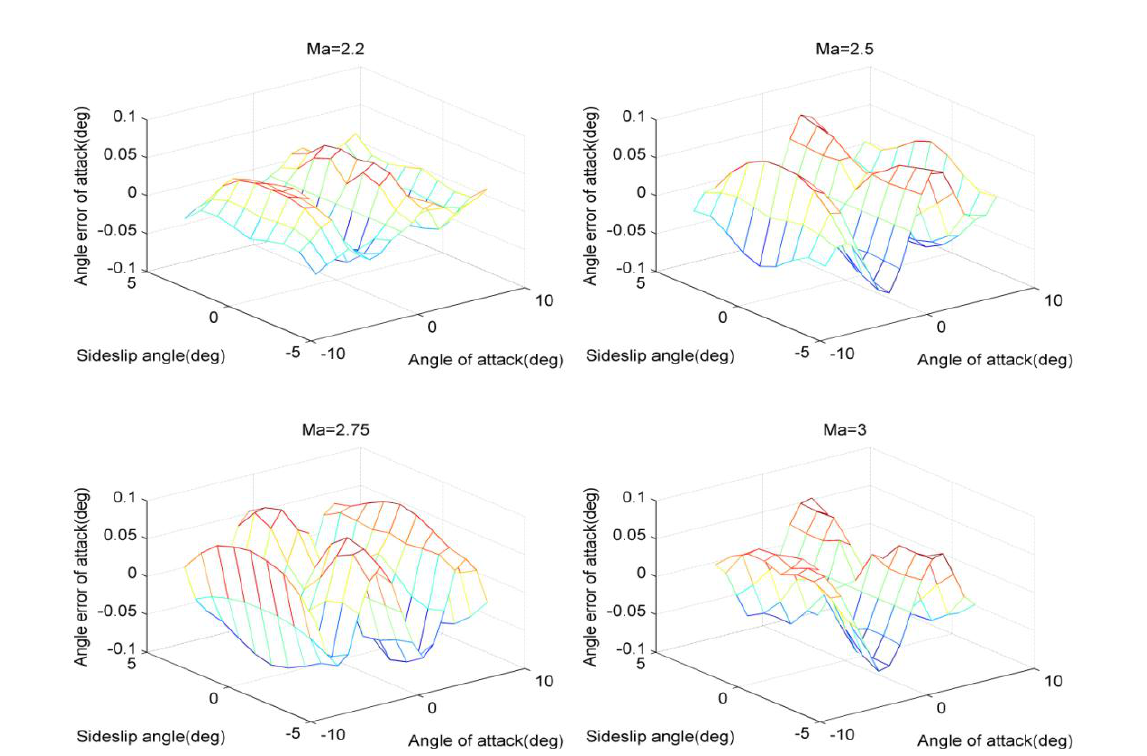
Figure 5. Change curves of angle errors of attack using three-point